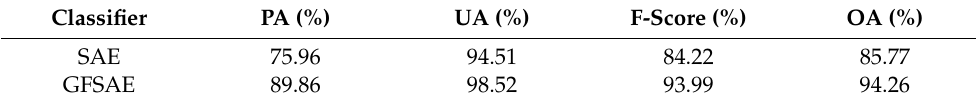
Table 7. Accuracy metrics of boundary areas for SAE and GFSAE for the Winnipeg